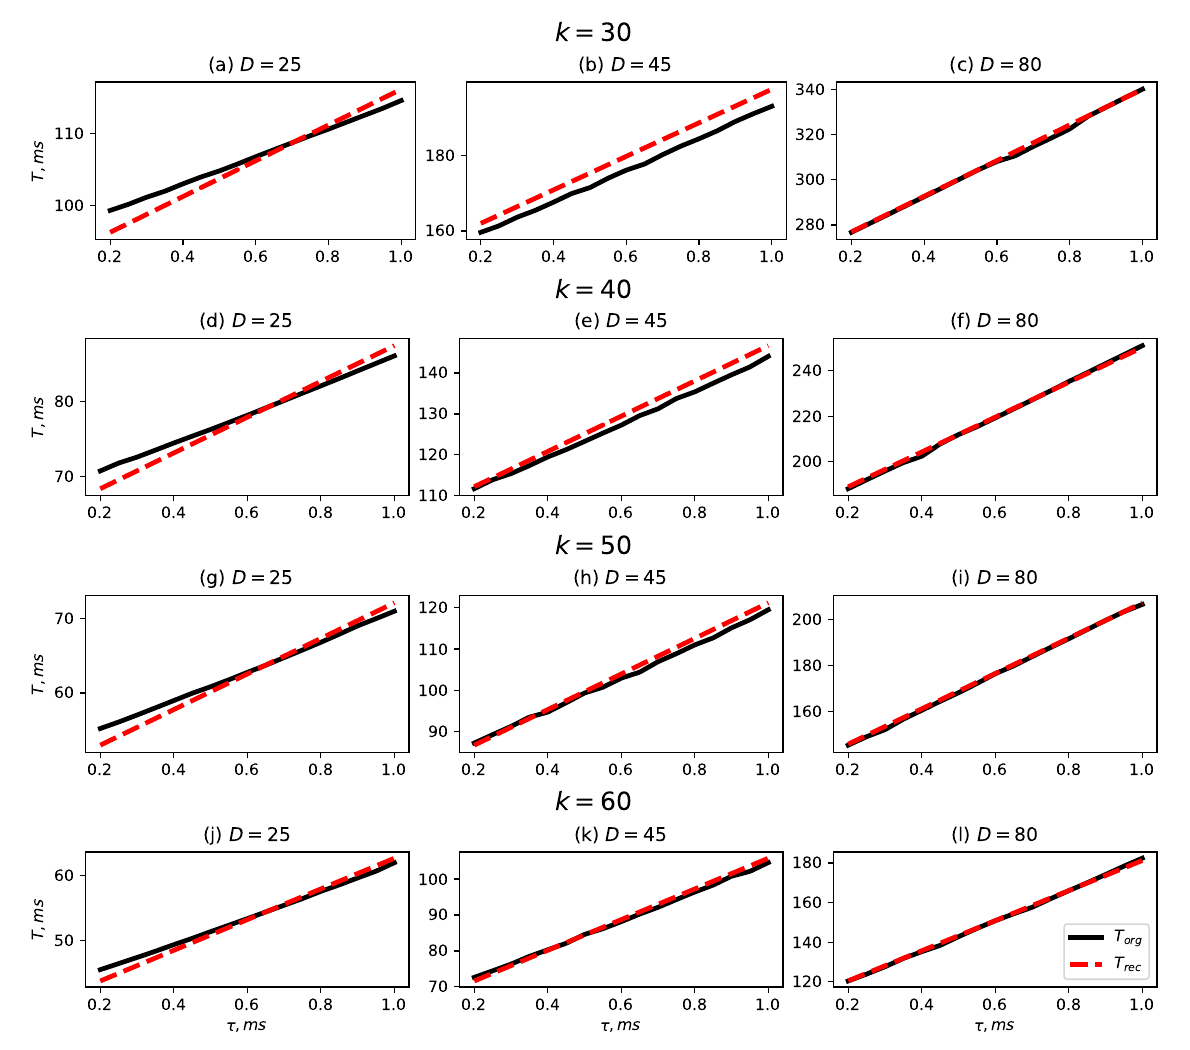
Figure 4. Comparison of the time series period of Hodgkin–Huxley neurons obtained as a result of the numerical experiments T (black lines) and reconstructed (red dashed lines) in accordance with the model (4) plotted at fixed D for the coupling coefficients k = 30 ( a – c ), k = 40 ( d – f ), k = 50 ( g – i ), and k = 60 ( j – l ),